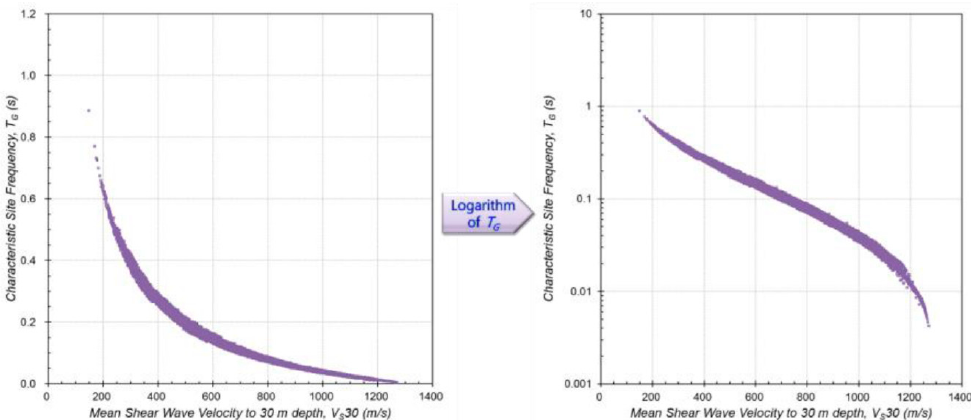
Figure 4. Correlation between the site period ( T G ) and V S 30 based on the spatial calculation site response information of Seoul.